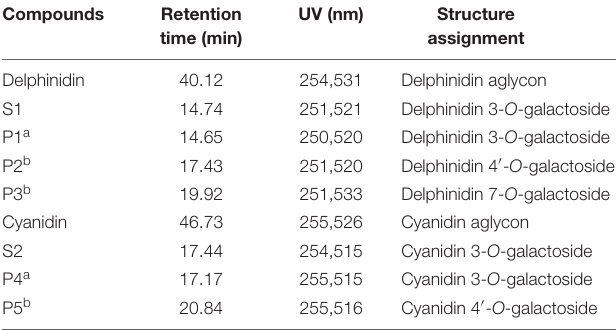
TABLE 3 | Structure assignment of Fh3GT1 reaction products.